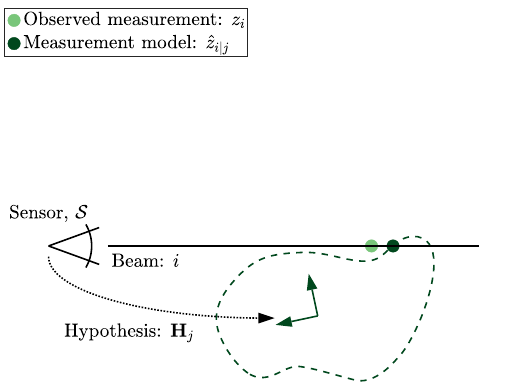
Figure 4. The expected range along the i -th beam for hypothesis H j is depicted as ˆ z i | j . A starting point is to consider the measurement uncertainty of the LiDAR sensor itself. Manufacturers will typically provide the standard deviation of sensor measurement uncertainty, σ .